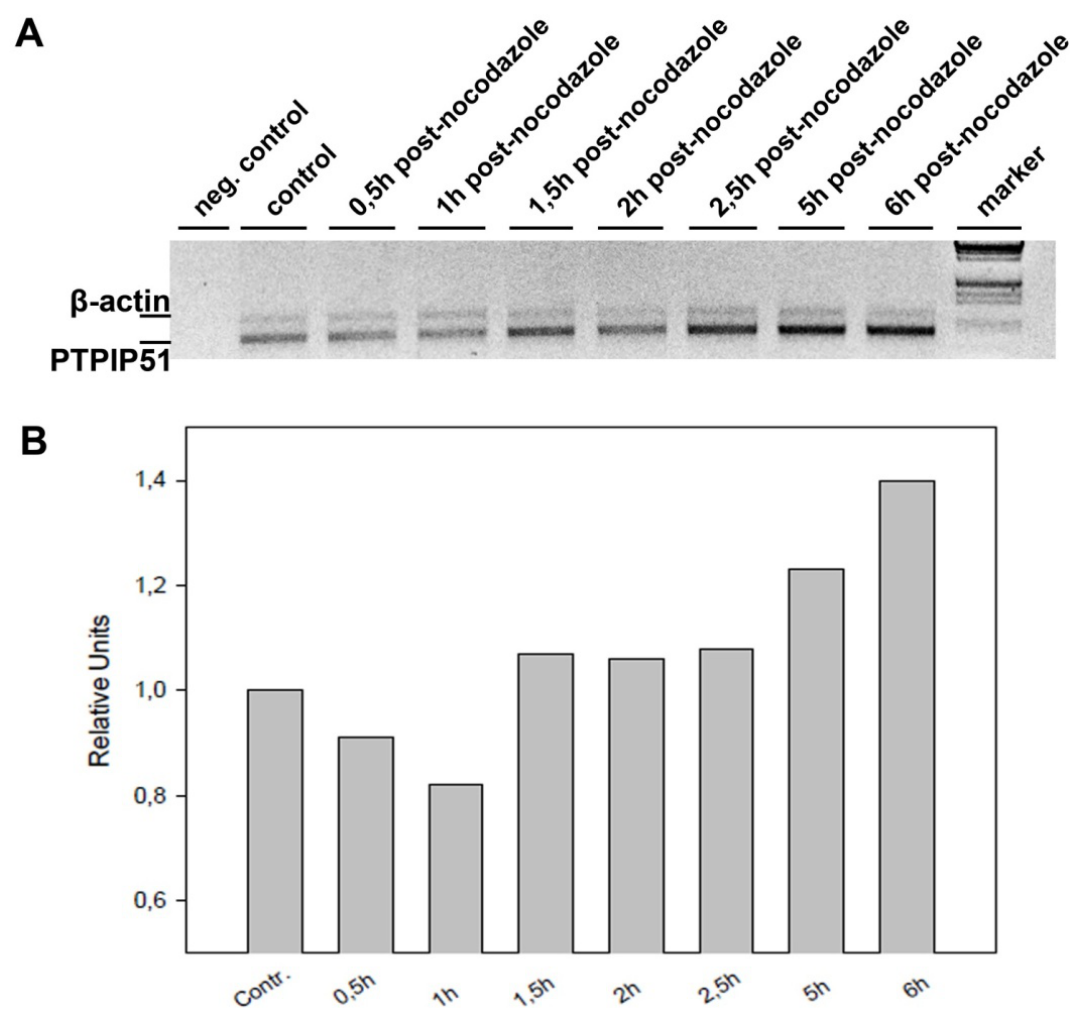
Figure 3. Quantitative reverse transcriptase polymerase chain reaction (qRT-PCR) of HaCat cell lysate harvested at distinct periods after nocodazole treatment. ( A ) Gel of the RT-PCR. Upper bands display β -actin and PTPIP51 mRNA is shown in the lower bands. ( B ) Relative values of PTPIP51 mRNA at different time points post-synchronization. The value for the control was set to 1. Samples were normalized to the control